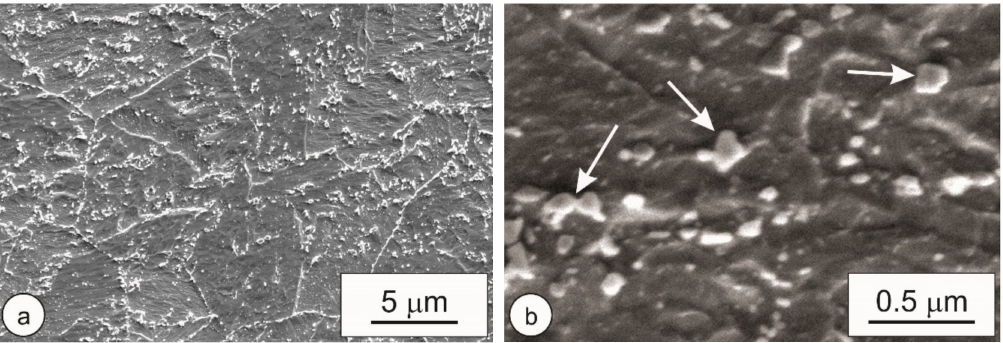
Figure 14. ( a ) SEM micrograph of the post weld heat treated FGHAZ-2; PWHT 2 h at 780 ◦ C; ( b ) White arrows point at some Cr, Fe, V and Mo-rich M 23 C 6 type carbide precipitates (analyzed by